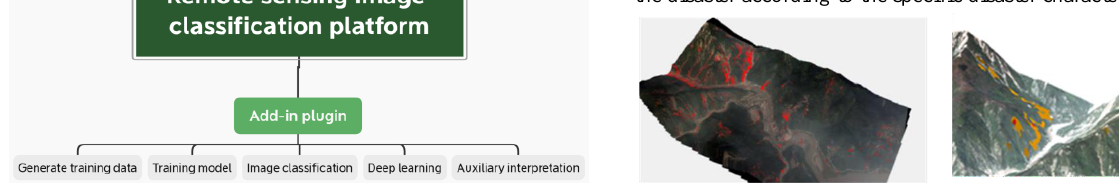
Figure 5. vegetation and three-dimensional terrain change detection in debris flow and landslide area